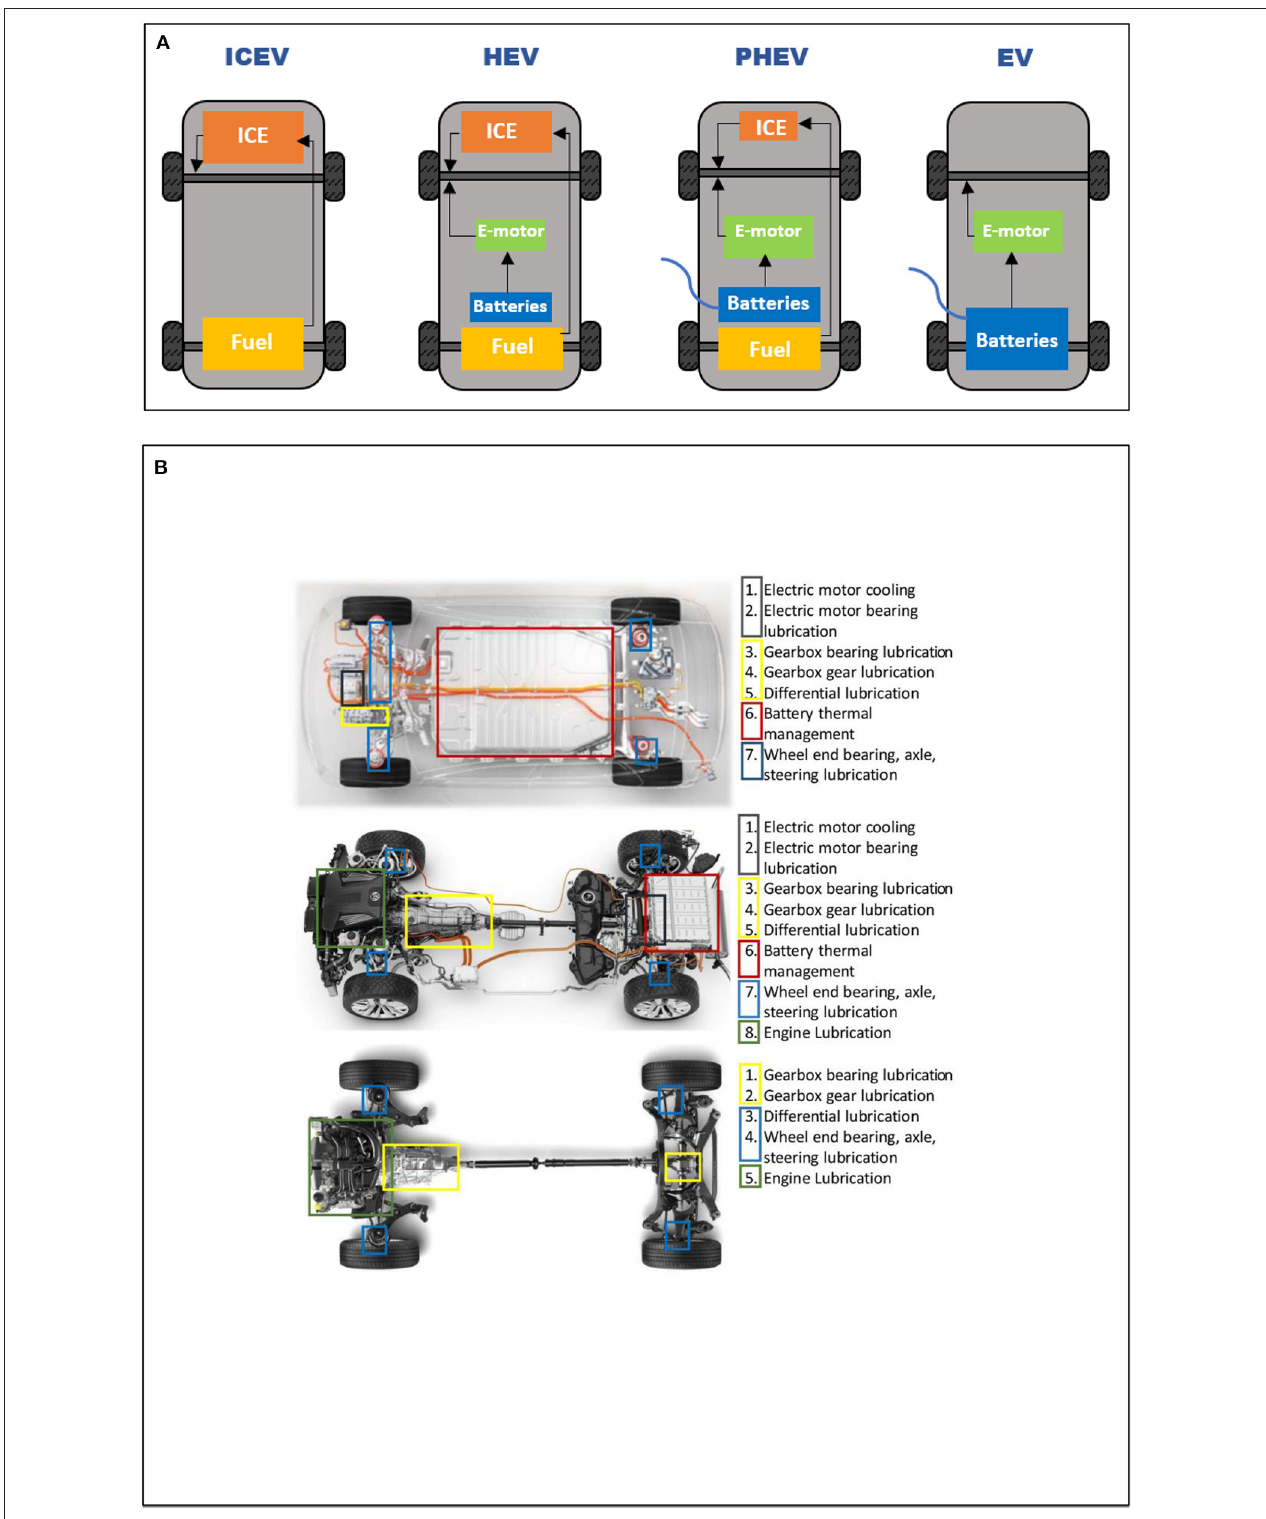
FIGURE 3 | (A) The illustration of electric drivetrains in comparison of the battery and IC engine sizes. (B) A representation of major components in EV, HEV, and ICEV where lubricants are applied ( B sources: top—Tesla; middle—Volkswagen netcarshow; bottom—Subaru Forester showroom).